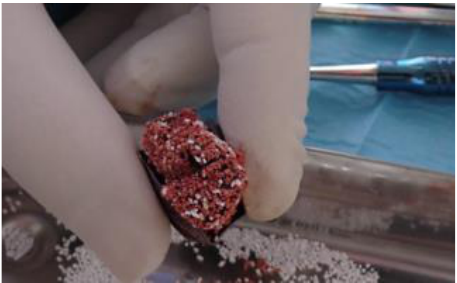
Figure 6. Barrier filled with clot and beta tricalcium phosphate. The barrier was fixed with appropriate screws.